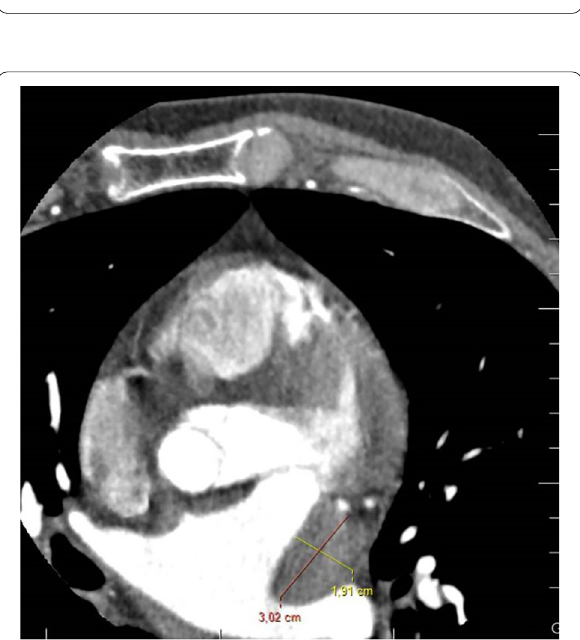
Fig. 4 Axial computed tomography (CT) imaging demonstrating a non-enhancing left atrial intramural mass consistent with